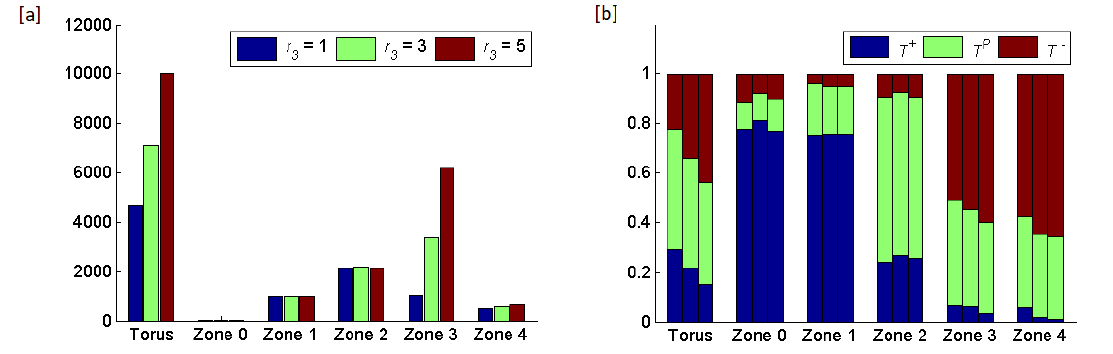
Figure 9. Results of increasing the radius of zone 3, r 3 , from 1 to 5, while keeping the radii of the other zones ( r 1 and r 2 ) at 3. ( a ) The total number of cells in the torus and in each zone. The average rates at which cells land in zone 0 and become circulating tumor cells are 2.95, 2.88, and 2.80 cells per generation, respectively, for r 3 equal 1, 3 and 5. ( b ) The frequencies of the three cell types per zone shown as triplets of stacked bars where the order of bars per triplet shows r 3 = 1,3,5 from left to the